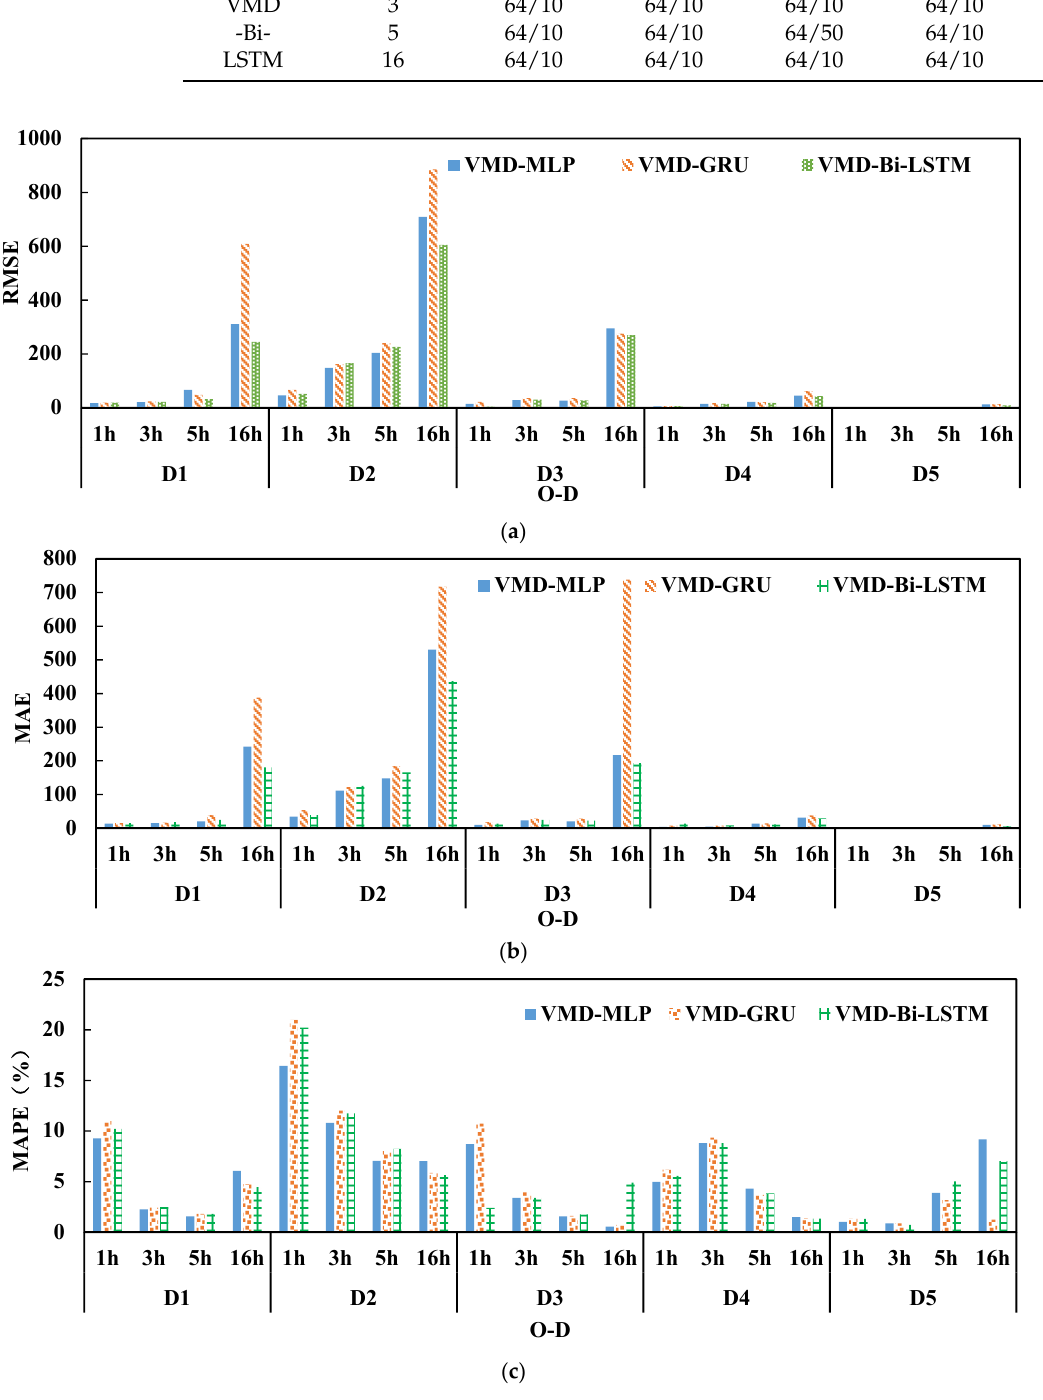
Figure 8. Comparison of the minimum values of the RMSE, MAE, and MAPE errors. ( a ) The minimum RMSE prediction error of each model for each O-D pair under different time granularities, ( b ) The minimum MAE prediction error of each model for each O-D pair under different time granularities, ( c ) The minimum MAPE prediction error of each model for each O-D pair under different time